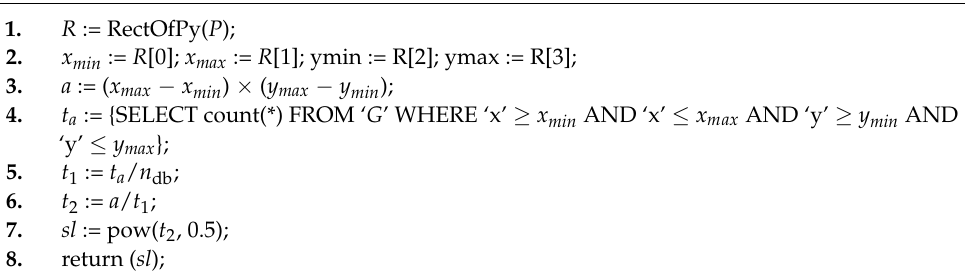
Algorithm 7. SqrSide(polygon P , point set G , number n db